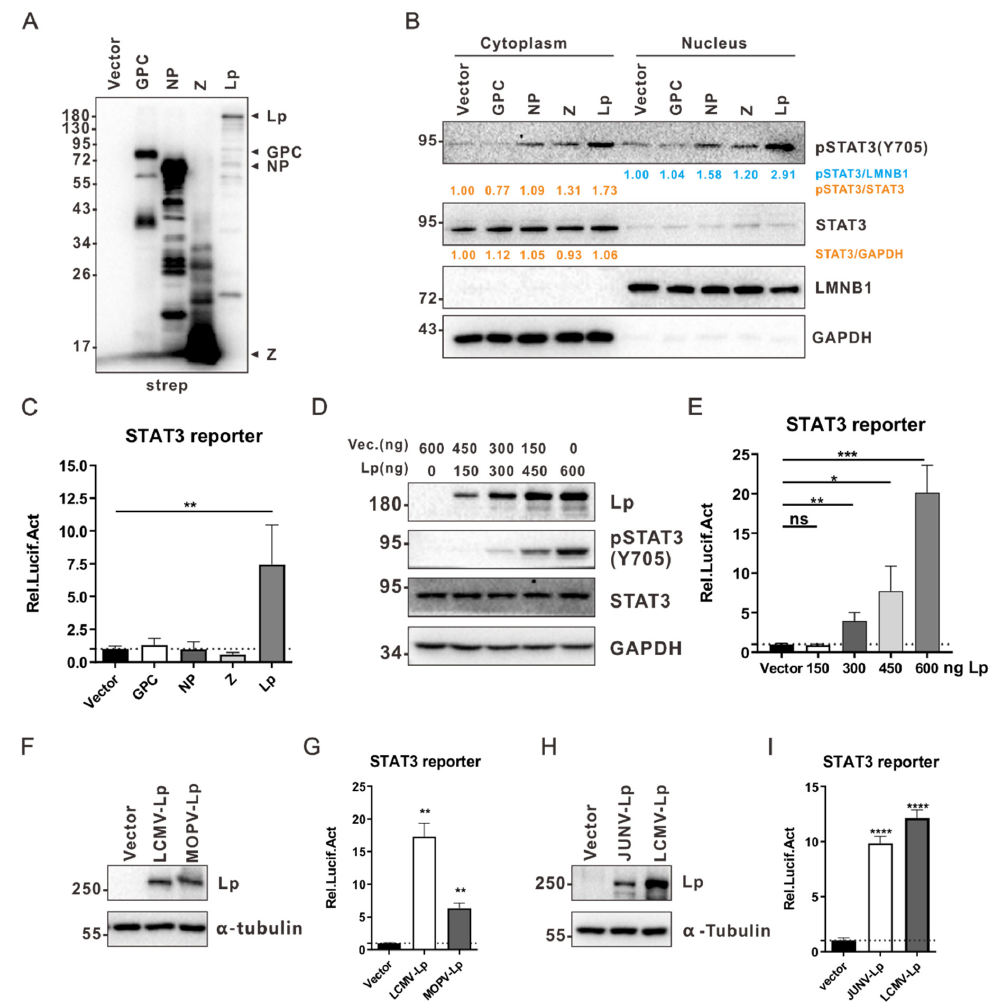
Figure 2. The activation of STAT3 signaling pathway is mediated by the L protein of LCMV. ( A ) HEK 293T cells in a well of a 6-well plate were transfected with 2.5 μ g of the indicated step-tag pCAGGs plasmids. At 36 h post transfection, cells were lysed and proteins were subjected to Western blot analysis. Expression levels of all viral proteins were detected with a mouse monoclonal antibody against the strep tag. ( B ) LCMV Lp promotes the nuclear translocation of pSTAT3 (Y705). HEK 293T cells were transfected with plasmids as in ( A ). At 36 h post transfection, cells were collected and then fractionated into nuclear and cytoplasmic fractions for Western blot analysis. To normalize the STAT3 protein intensity, lamin B1 and GAPDH were used as the nuclear and cytoplasmic endogenous loading controls, respectively. Relative protein intensity was analyzed using the ImageJ software. ( C ) LCMV Lp activates STAT3 reporter activity. HEK 293T cells in a well of a 24-well plate were transfected with STAT3 reporter plasmid (20 ng) and indicated viral protein-expressing plasmids (480 ng). At 36 h post transfection, cells were lysed and subjected to luciferase assays to measure the STAT3 reporter activity. ( D , E ) LCMV Lp activates STAT3 in a dose-dependent manner. HEK 293T cells were transfected with STAT3 reporter plasmid ( E ) and an indicated dose of pCAGGs-LCMV-Lp-strep plasmids. pCAGGs-strep (Vector) was added to ensure that each transfection received the same amount of total DNA. At 36 h post transfection, cells were lysed and subjected to luciferase assays to measure the STAT3 reporter activity. ( F – I ) The effect of MOPV-Lp or JUNV-Lp on STAT3 activation. HEK 293T cells in a well of a 24-well plate were transfected with 20 ng of STAT3 reporter plasmid ( G , I ) and 480 ng of pCAGGs-strep (Vector), pCAGGs-LCMV-Lp-strep, pCAGGs-MOPV-Lp-strep, or pCAGGs-JUNV-Lp-strep. The expression of Lp was measured by Western blotting ( F , H ), while the STAT3 reporter activity was measured by a luciferase assay ( G, I ). A representative from at least two independent experiments is shown. Graphs show mean ± SD. ( n = 3, C , E , G , I ) * p < 0.05, ** p < 0.01, *** p < 0.001, **** p < 0.0001, ns not significant, unpaired Student’s t -test.